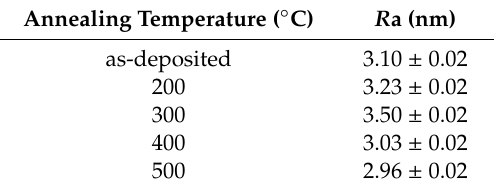
Figure 6. SEM images of as-deposited and annealed Ti:SnO 2 films: ( a ) as-deposited, ( b ) annealed at 200 ◦ C, ( c ) annealed at 300 ◦ C, ( d ) annealed at 400 ◦ C, and ( e ) annealed at 500 ◦ C. Table 3. E ff ects of annealing temperature on surface roughness of Ti:SnO 2